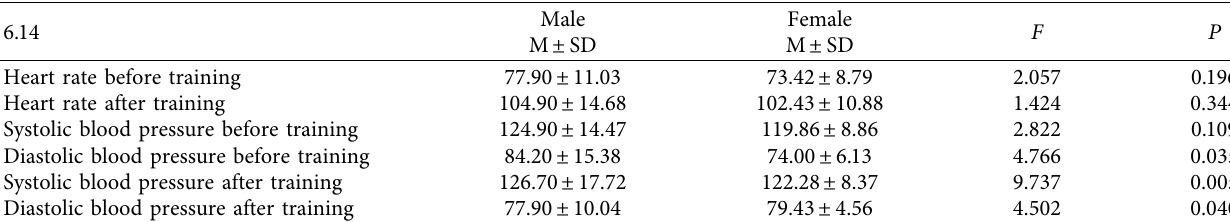
a test table about the difference in heart rate and blood pressure between male and female athletes.